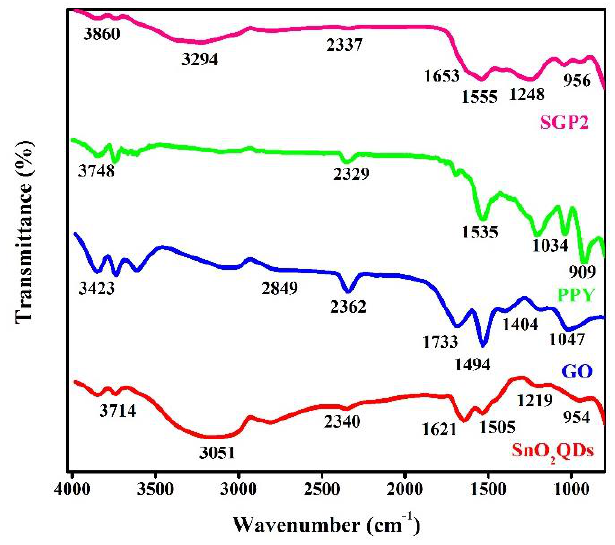
Figure 1. FTIR spectra of pure SnO 2 QDs, GO, PPy, and SGP2 composite. A distinctive peak at 3423 cm − 1 caused by the O-H group’s presence in the GO. The peaks at 1733 cm − 1 and 1047 cm − 1 , respectively, indicate the COOH (carboxy) and C-O-C (epoxide). In addition, 1494 cm − 1 represents the remaining sp 2 carbon in graphite. The PPy has two bands: one at 1034 cm − 1 , which corresponds to the stretching vibration of the C-N in-plane ring vibration with high conjugation, and one at 1535 cm − 1 , which corresponds to the C-C bending vibration [27]. Furthermore, =C-N out of plane deformation is represented by the band seen near 909 cm − 1 [28]. The formation of polypyrrole is confirmed by the band at 3748 and 2329 cm − 1 , which is due to the N-H and C-H stretching vibrations [29]. The peak of SGP2 at 956 cm − 1 can be attributed to the ring stretching mode of PPy present in the composite and 1653 cm − 1 assigned from the O-H stretching of SnO 2 present in the composite. Therefore, FTIR results show the presence of SnO 2 , GO, PPy in the ternary SGP2